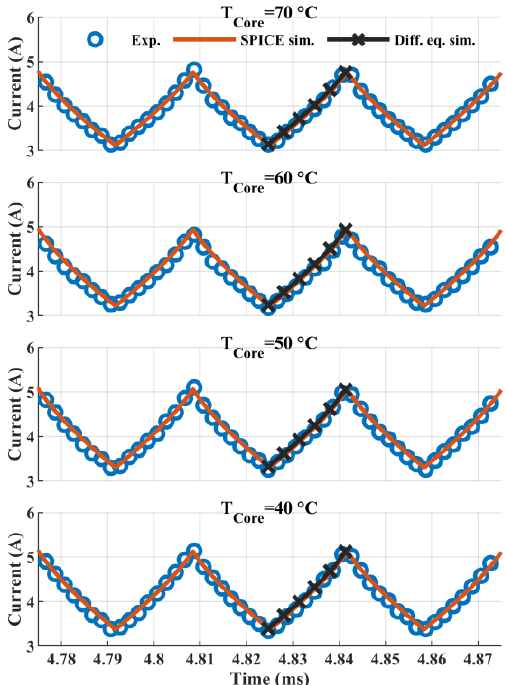
Figure 9. Comparison of the experimental current waveform with the simulation results from SPICE and the differential equation for a duty cycle of 50% at different temperatures.